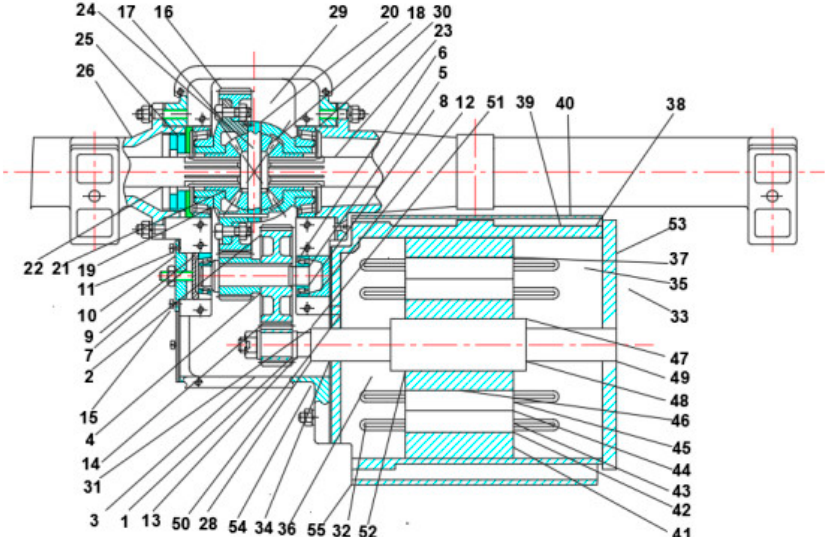
Figure 1. The structure of the two-axle automobile drive axle.